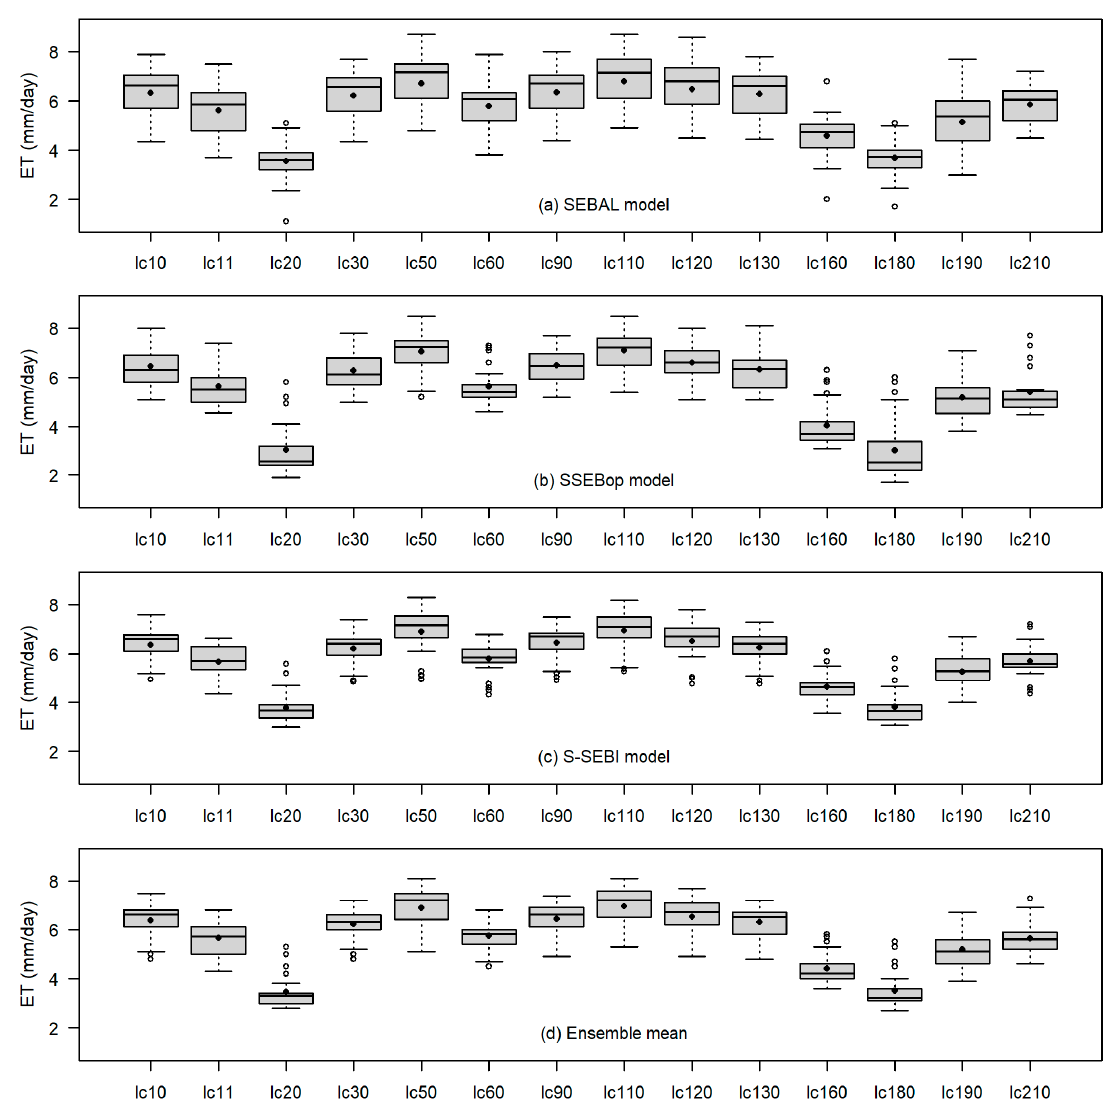
Figure 3. The boxplots showing variations of actual evapotranspiration (ET) estimates for 25 satellite overpasses (i.e., image acquisition dates) computed by Surface Energy Balance (SEB) models, and their ensemble mean across di ff erent land cover classes in the Kilombero Valley (KV) river basin. The height of the box indicates the Interquartile range (IQR) of ET values, the horizontal line inside the box indicates the median ET value, the upper box level indicates the upper quartile (75th percentile), the lower box level indicates the lower quartile (25th percentile), bars (whiskers) indicate the minimum and maximum ET values, a filled circle indicates the mean ET value, and an open circle indicates the outlier. SBL, Surface Energy Balance Algorithm for Land (SEBAL) model; SOP, Operational Simplified Surface Energy Balance (SSEBop) model; SSB, Simplified Surface Energy Balance Index; lc, land cover. The number after prefix‘lc’intheabscissaisthestandardvalueforagivenlandcoverclassprovidedbytheEuropeanSpace Agency (ESA) Climate Change Initiative (CCI) (http: // maps.elie.ucl.ac.be / CCI / viewer / download.php, accessed on 14th January 2019). ( a ) ET estimated using the SEBAL model ( b ) ET estimated using the SSEBop model ( c ) ET estimated using the S-SEBI model, and ( d ) ET estimated using the ensemble mean of the three